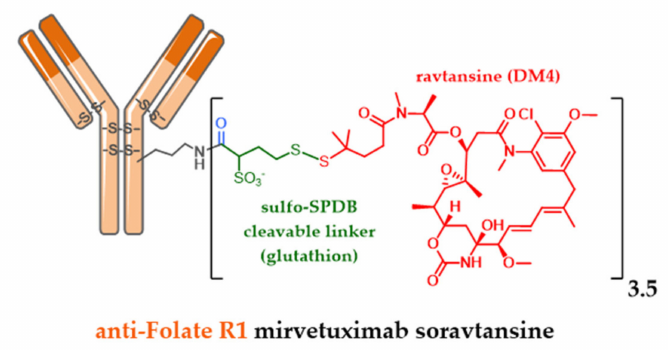
Figure 12. Formula of mirvetuximab soravtansine, antifolate R1 antibody conjugated to DM4 via a non-cleavable